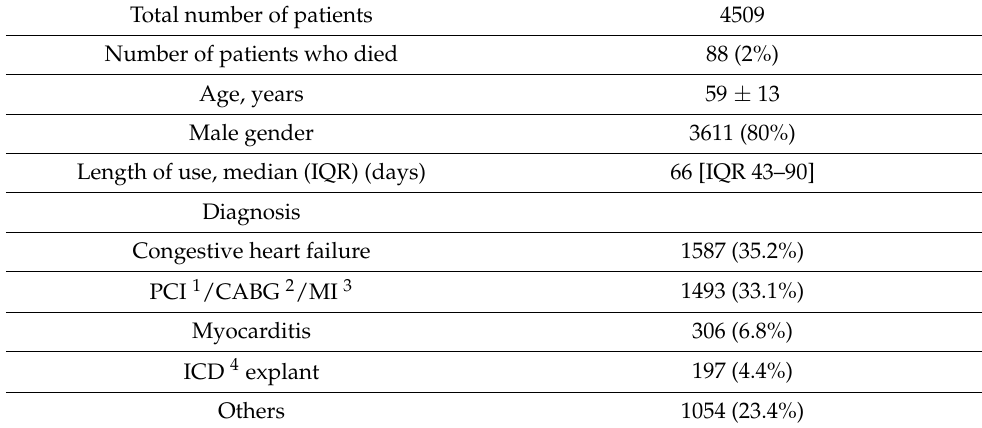
Table 1. Clinical